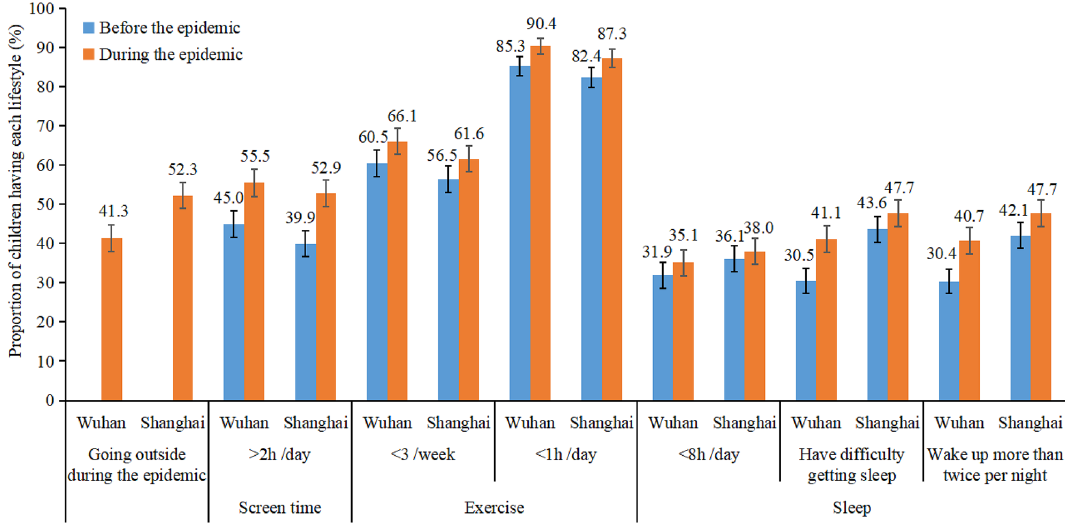
Figure 2. Comparing the proportions of children having unhealthy lifestyles before and during the COVID-19 epidemic. Note: Percentage (%) and 95% confidence interval were